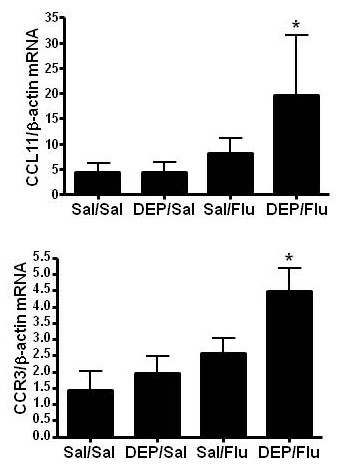
Exposure to DEP prior to infection with influenza increases markers of eosinophils chemotaxis. Total mouse lung RNA was analyzed for A.) CCL11 and B.) CCR3 mRNA levels and normalized to β-actin mRNA levels. *significantly different from Sal/Sal control; p < 0.05.